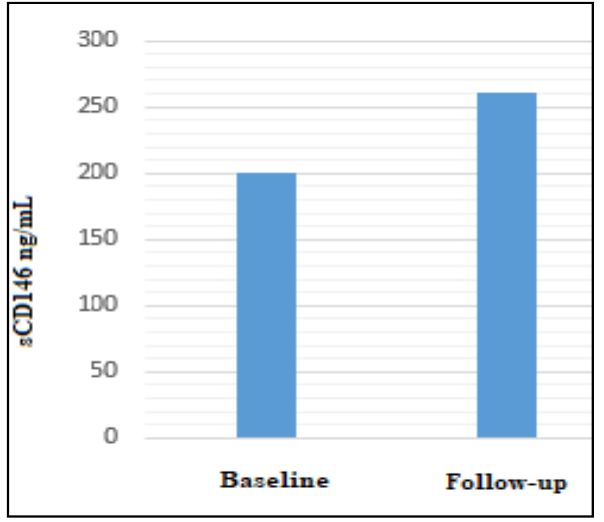
Figure 3. Bar graph showing the distribution of sCD146 concentrations in the two patient sera groups: